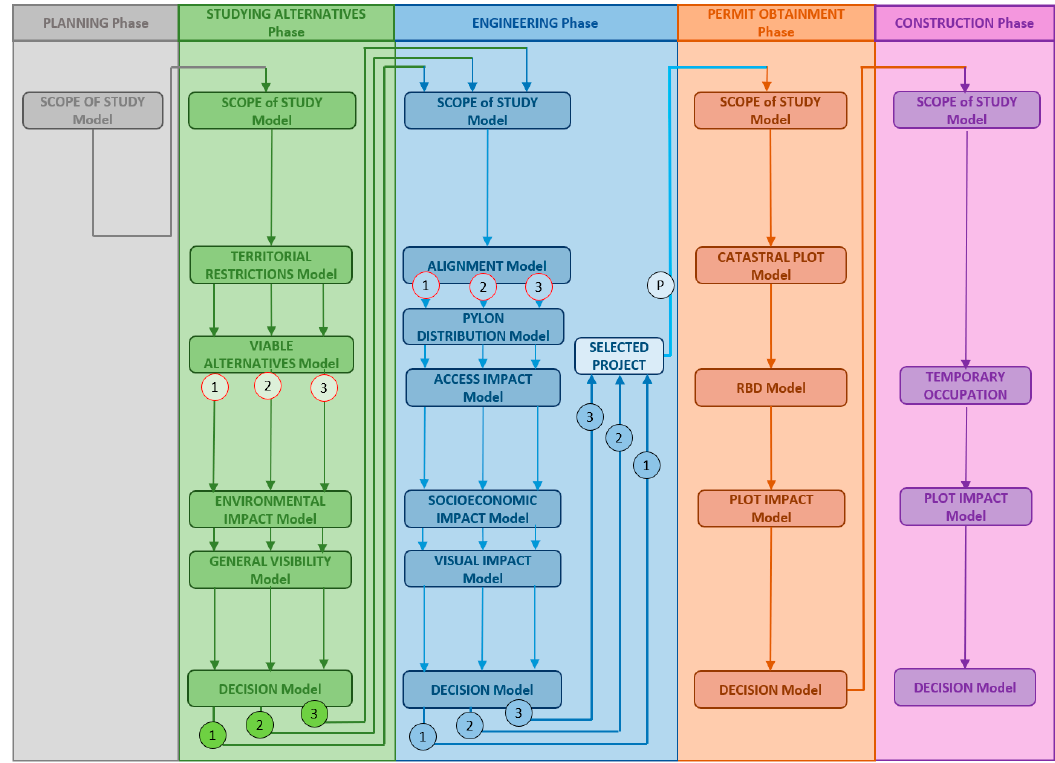
Figure 1. The geodesign-based workflow of the high-voltage transmission lines (HVTL) [4] with the models in each phase of the projects.